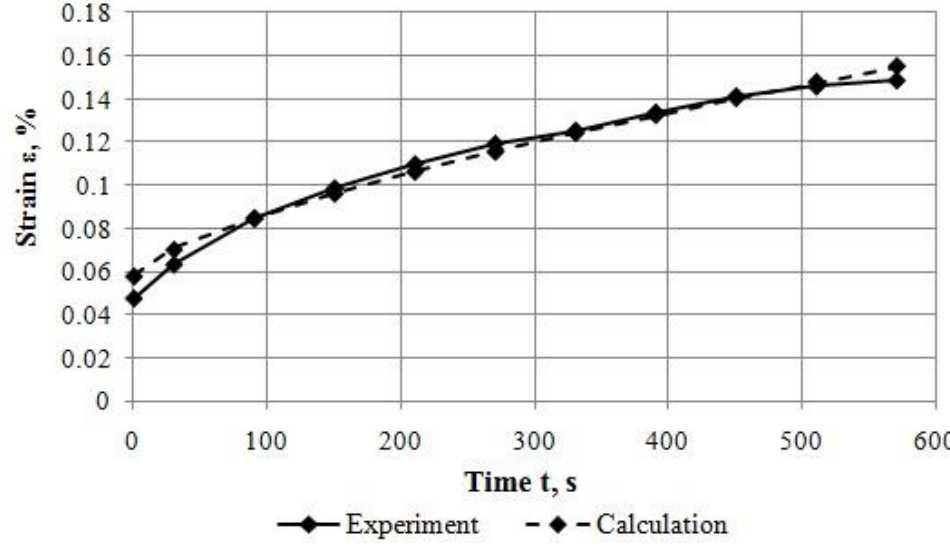
Figure 10. Experimental and calculated creep curves of the asphalt concrete at stress 0.041 MPa.